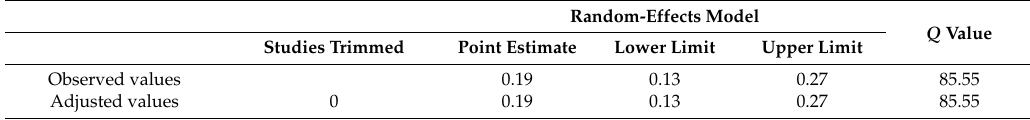
Table 6. Duval and Tweedie’s trim-and-fill analysis for binge drinking rate among truck drivers. Figure 5. Funnel plot for binge drinking among truck-drivers, showing no evidence of publication bias.